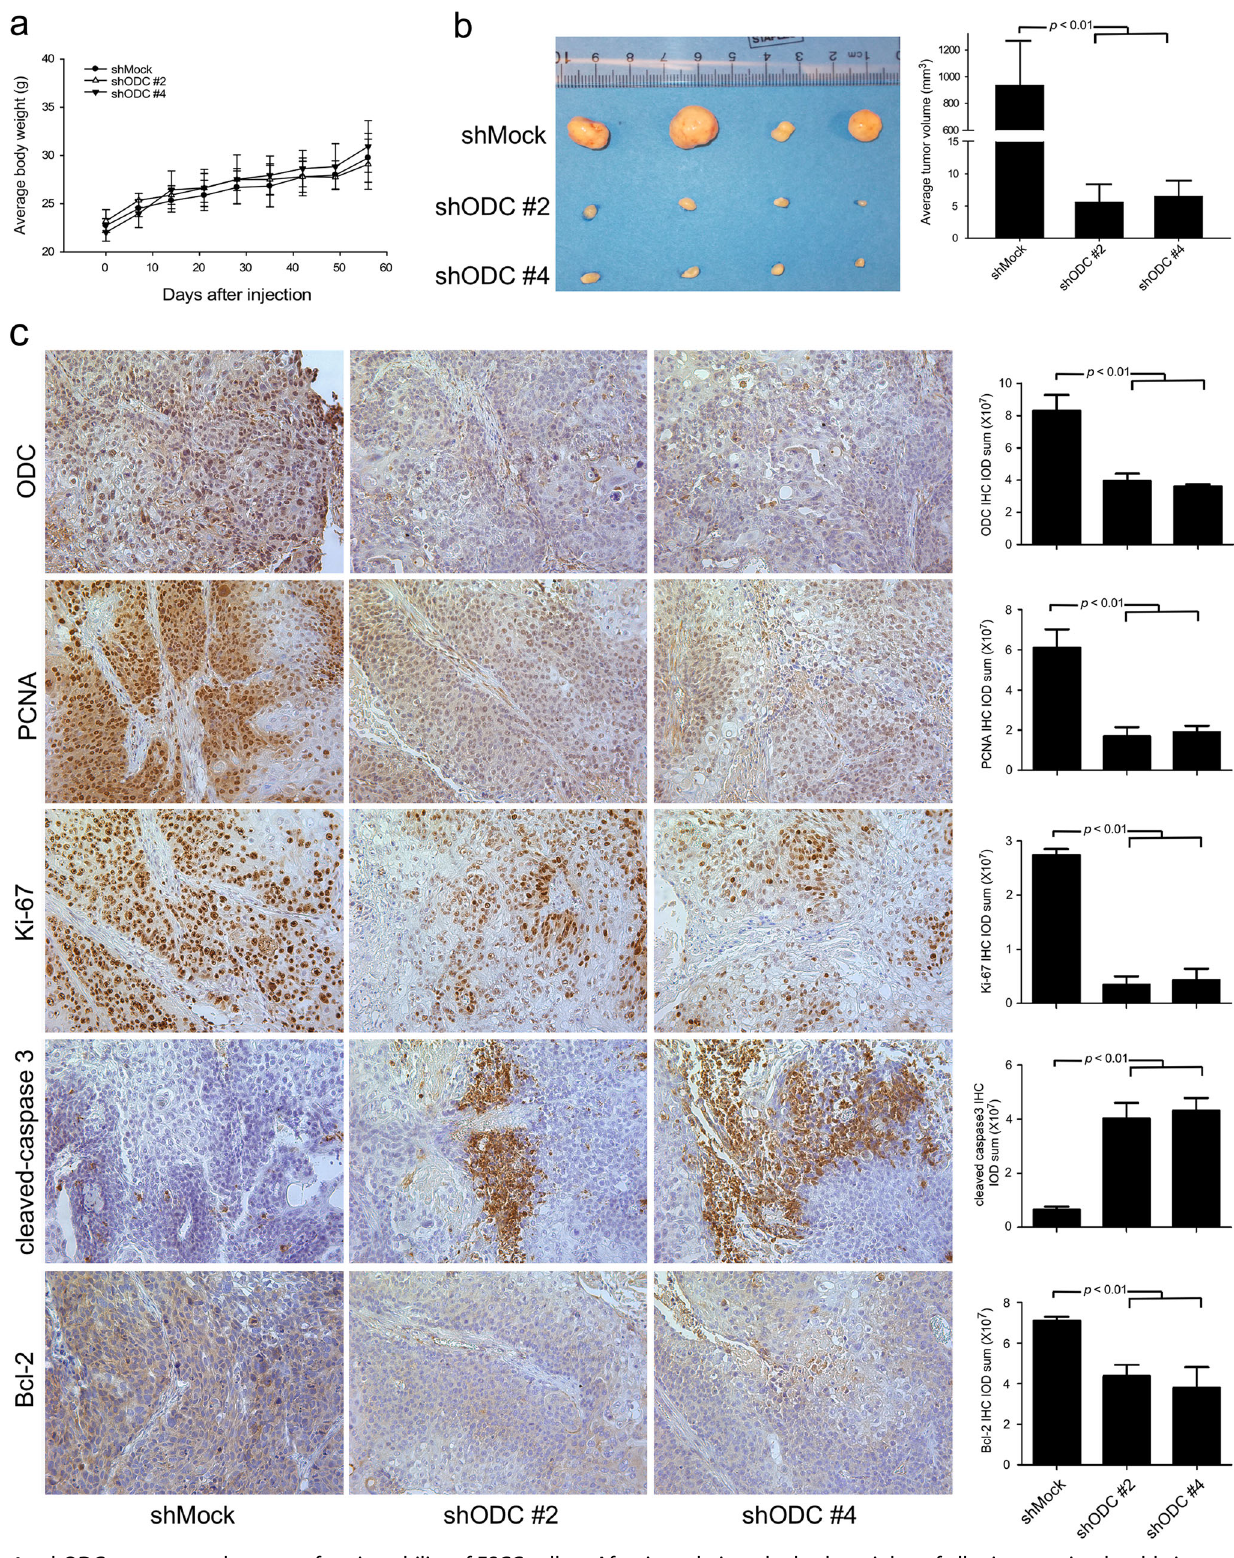
Fig. 4 shODC suppresses the tumor-forming ability of ESCC cells. a After inoculation, the body weights of all mice remained stably increased. b shODC signi fi cantly suppresses KYSE450 xenograft tumor volume compared with the shMock group. c IHC analysis was performed to determine the expression levels of ODC, PCNA, Ki-67, cleaved caspase 3, and Bcl-2 in ESCC xenograft tumors expressing shMock or shODC . Representative photographs for each antibody and each group are shown. The integrated optical density (IOD) was evaluated using the Image-Pro Plus software (v.6.0) program. All data are shown as mean values ±